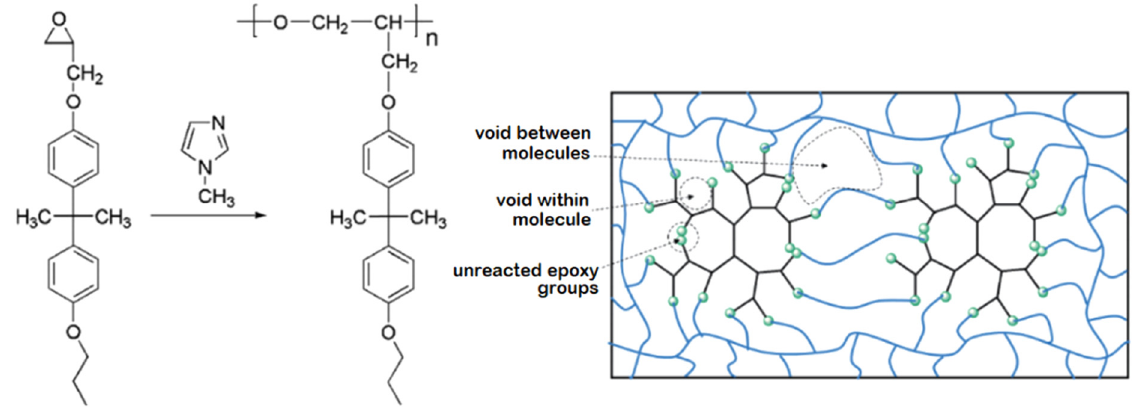
Figure 10: Homopolymerization of DGEBA with EHBPE catalyst and epoxy structure prediction after the completed curing process. Homopolymerization has always left an unreacted epoxy group [ 54 ]